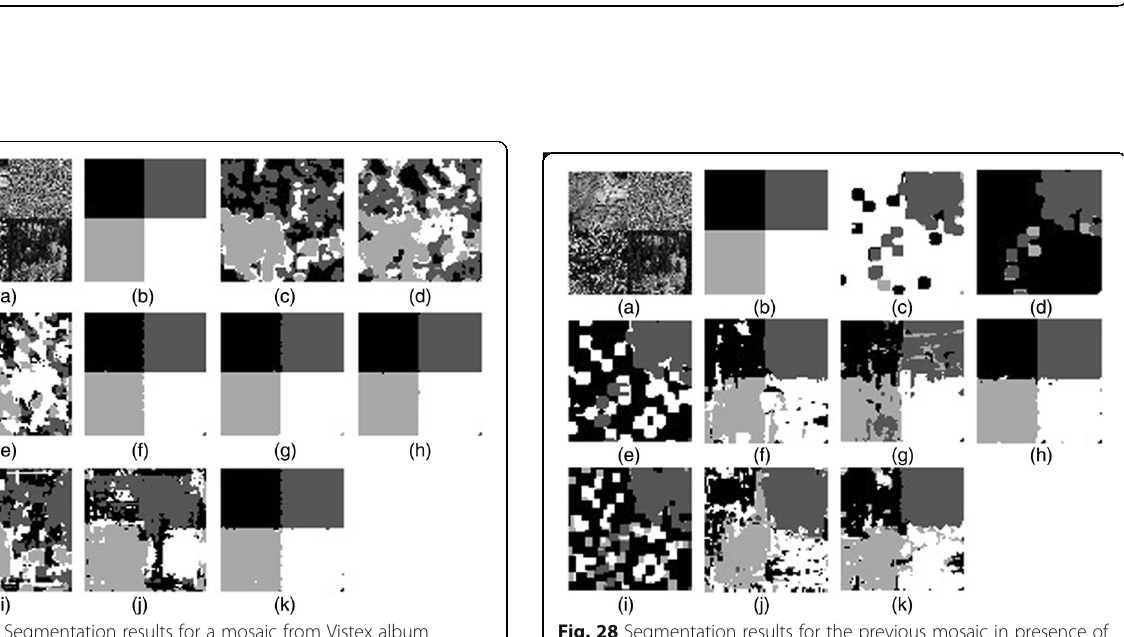
Fig. 26 Segmentation results for the previous mosaic in presence of Gaussian noise with density of 0.3. a Original image. b Hand-segmented image. c Gaussian features. d Rayleigh features. e Alpha-stable features. f Gaussian + contourlet features. g Rayleigh + contourlet features. h Alpha-stable + contourlet features. i Fractal dimension. j Fractal + contourlet. k Alpha-stable + wavelet